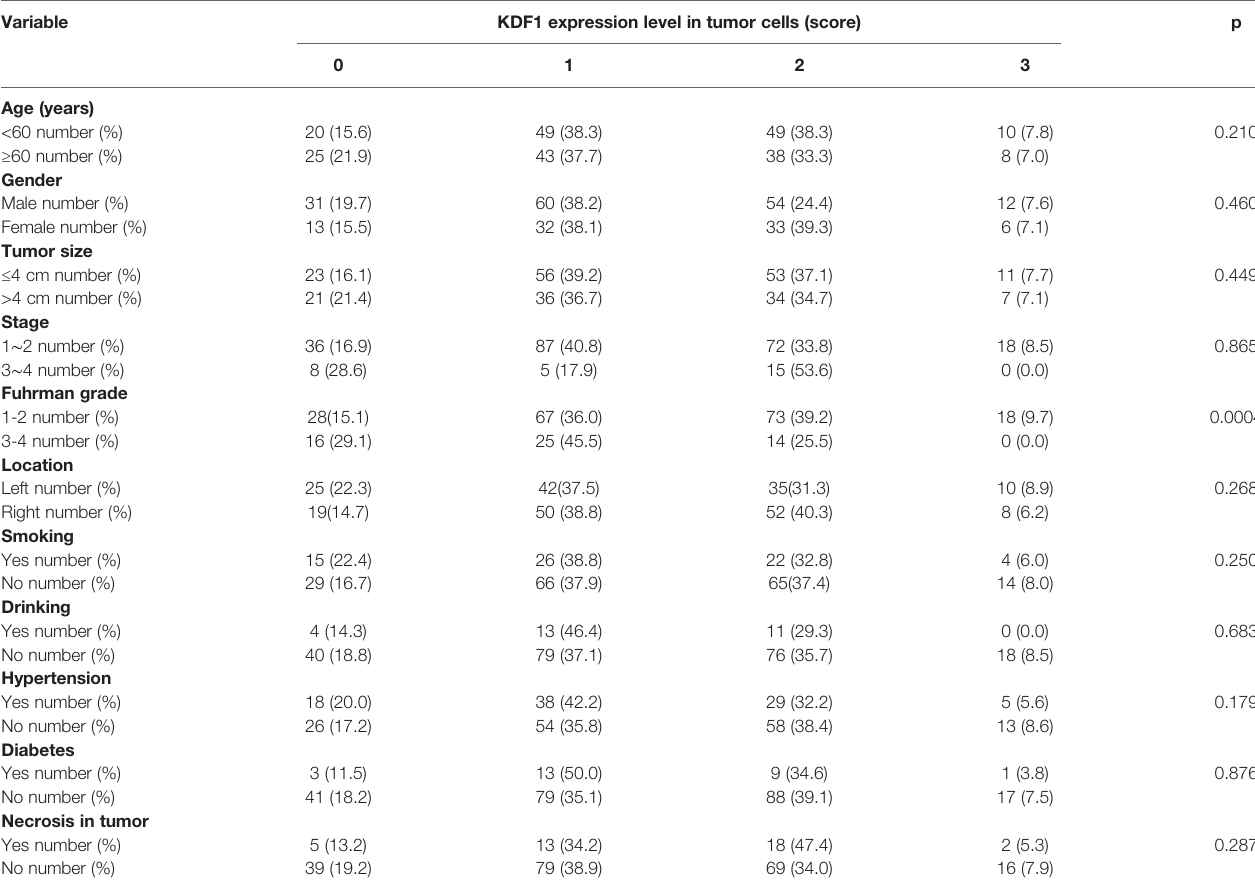
TABLE 1 | Association between KDF1 protein expression level and clinicopathological parameters. Variable KDF1 expression level in tumor cells